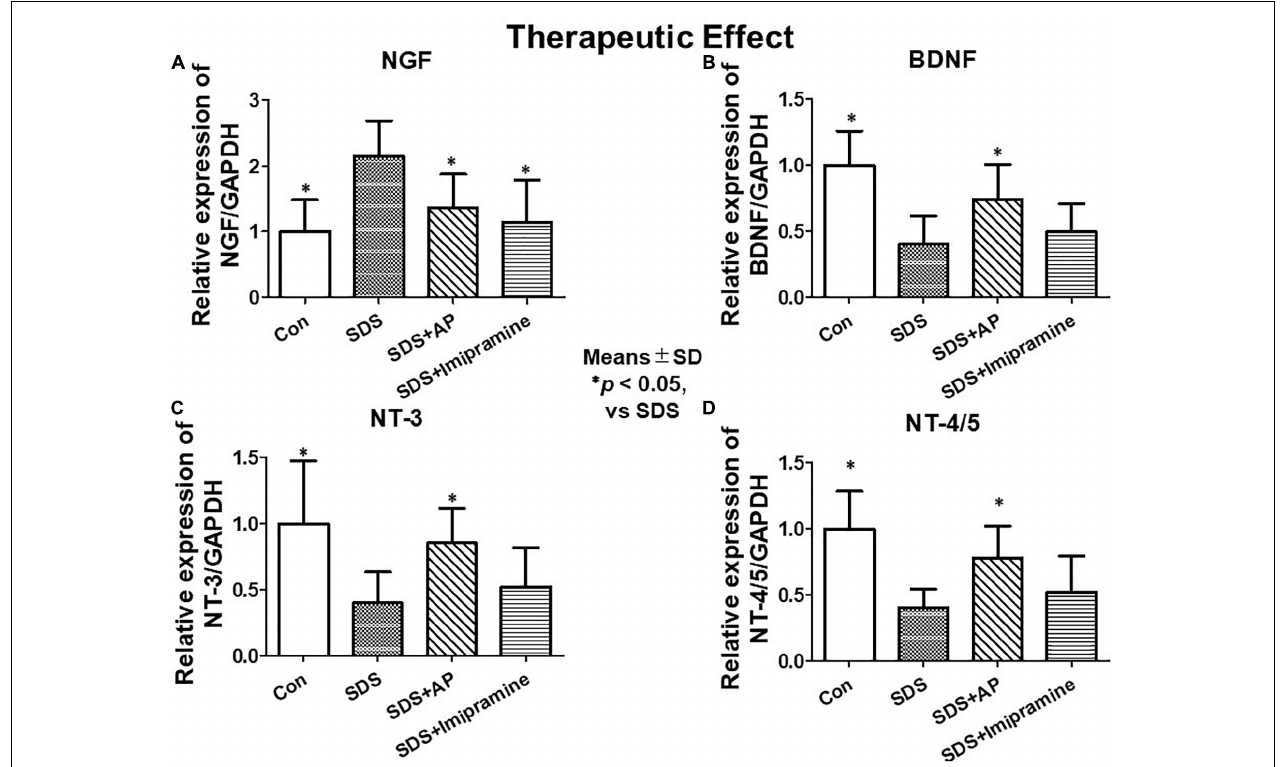
FIGURE 8 | mRNA expressions of neurotrophic factors in the brain after treatment of depression in SDS mice quantified by real-time PCR. (A) NGF, (B) BDNF, (C) NT-3, (D) NT-4/5. Results are expressed as relative gene expression levels of mRNA. Values are means ± SD ( n = 8). ∗ p < 0.05 versus SDS group. AP, acupuncture, BDNF, brain-derived neurotrophic factor; GAPDH, glyceraldehyde 3-phosphate dehydrogenase; NGF, Nerve growth factor; NT, Neurotrophin; SD, standard deviation; SDS, social defeat